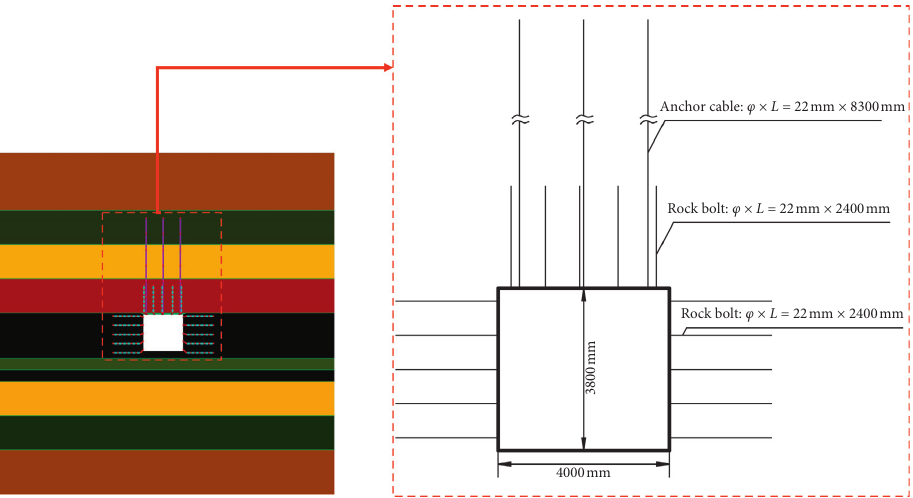
Figure 22: Support scheme design of numerical simulation.